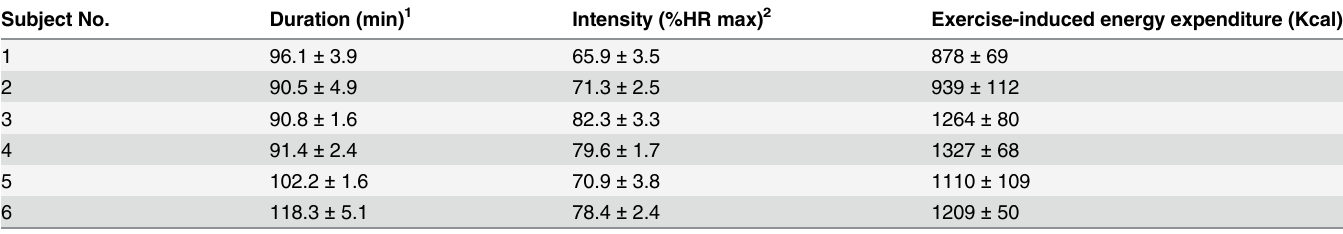
Table 4. Summary of the endurance exercise stimulus in individual subjects. Values are means ±